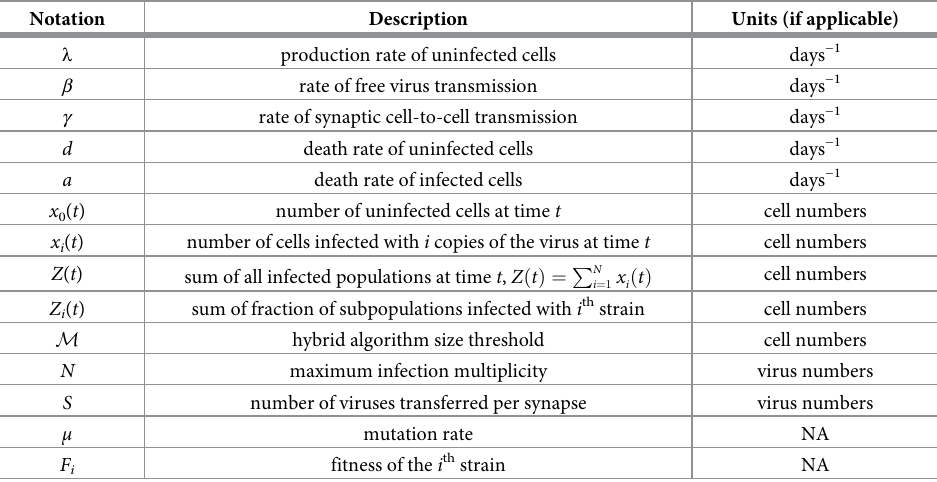
Table 1. Description of model parameters and units (if